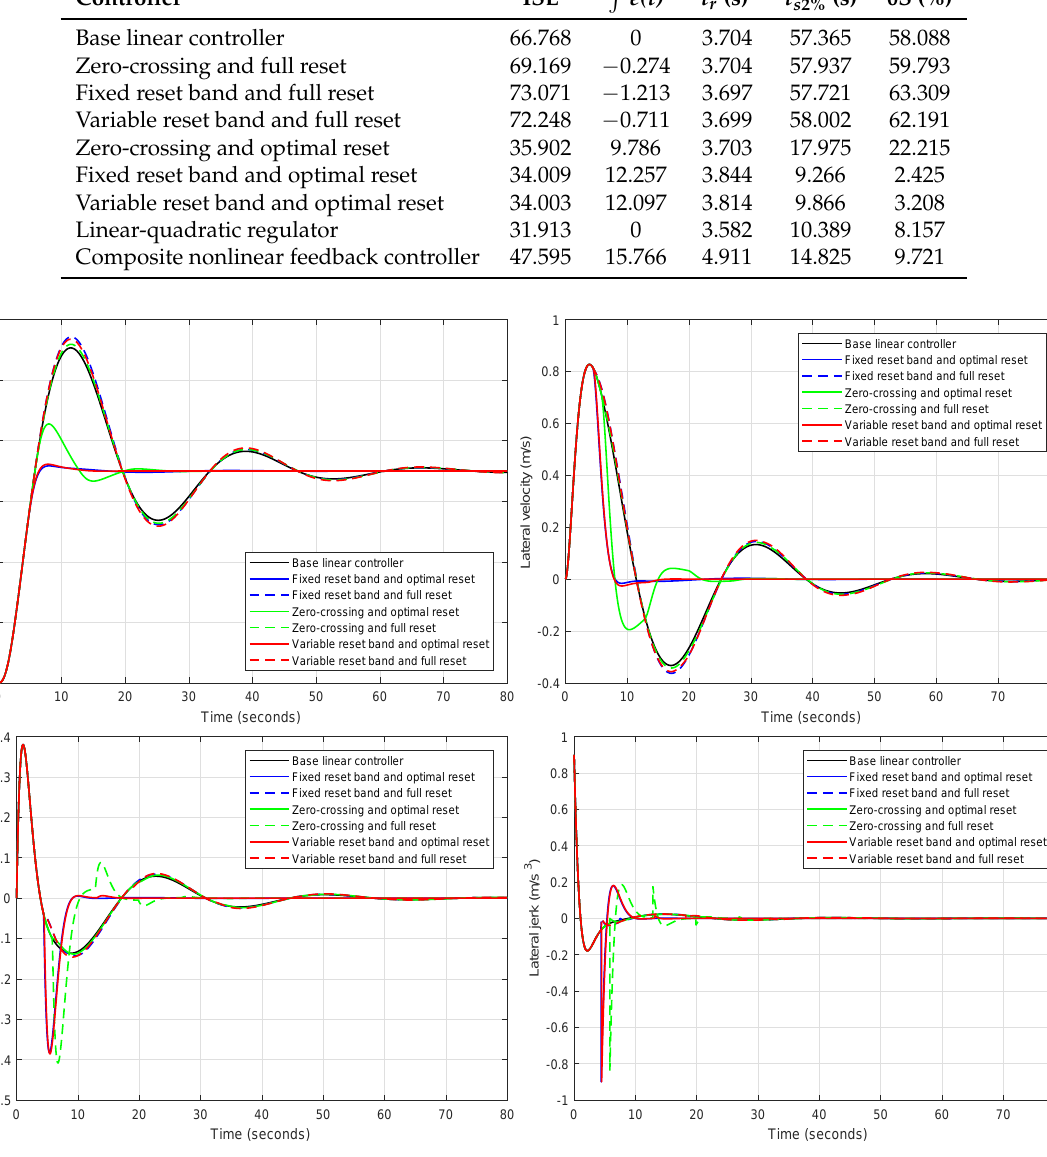
Figure 23. Position, velocity, acceleration and jerk for different reset controllers in